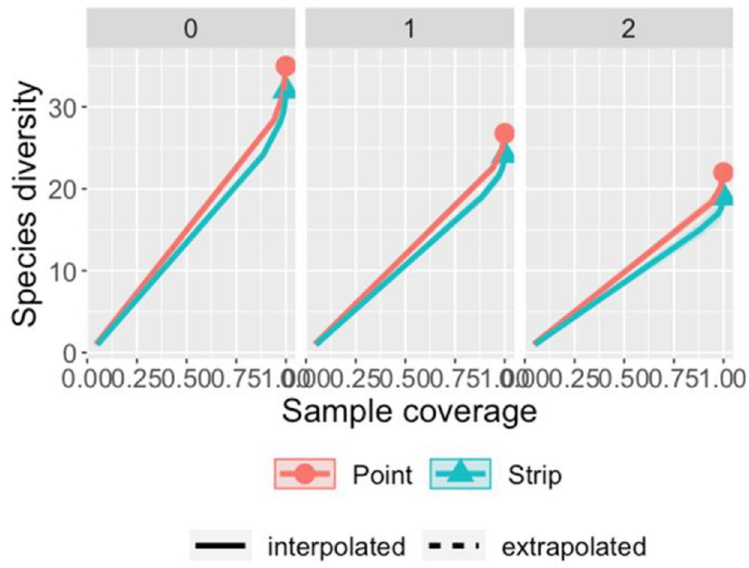
Fig 5. Sample coverage concerning species diversity of raptors in winter seasons using roadside point count and strip transect methods in the arid region of Rajasthan.